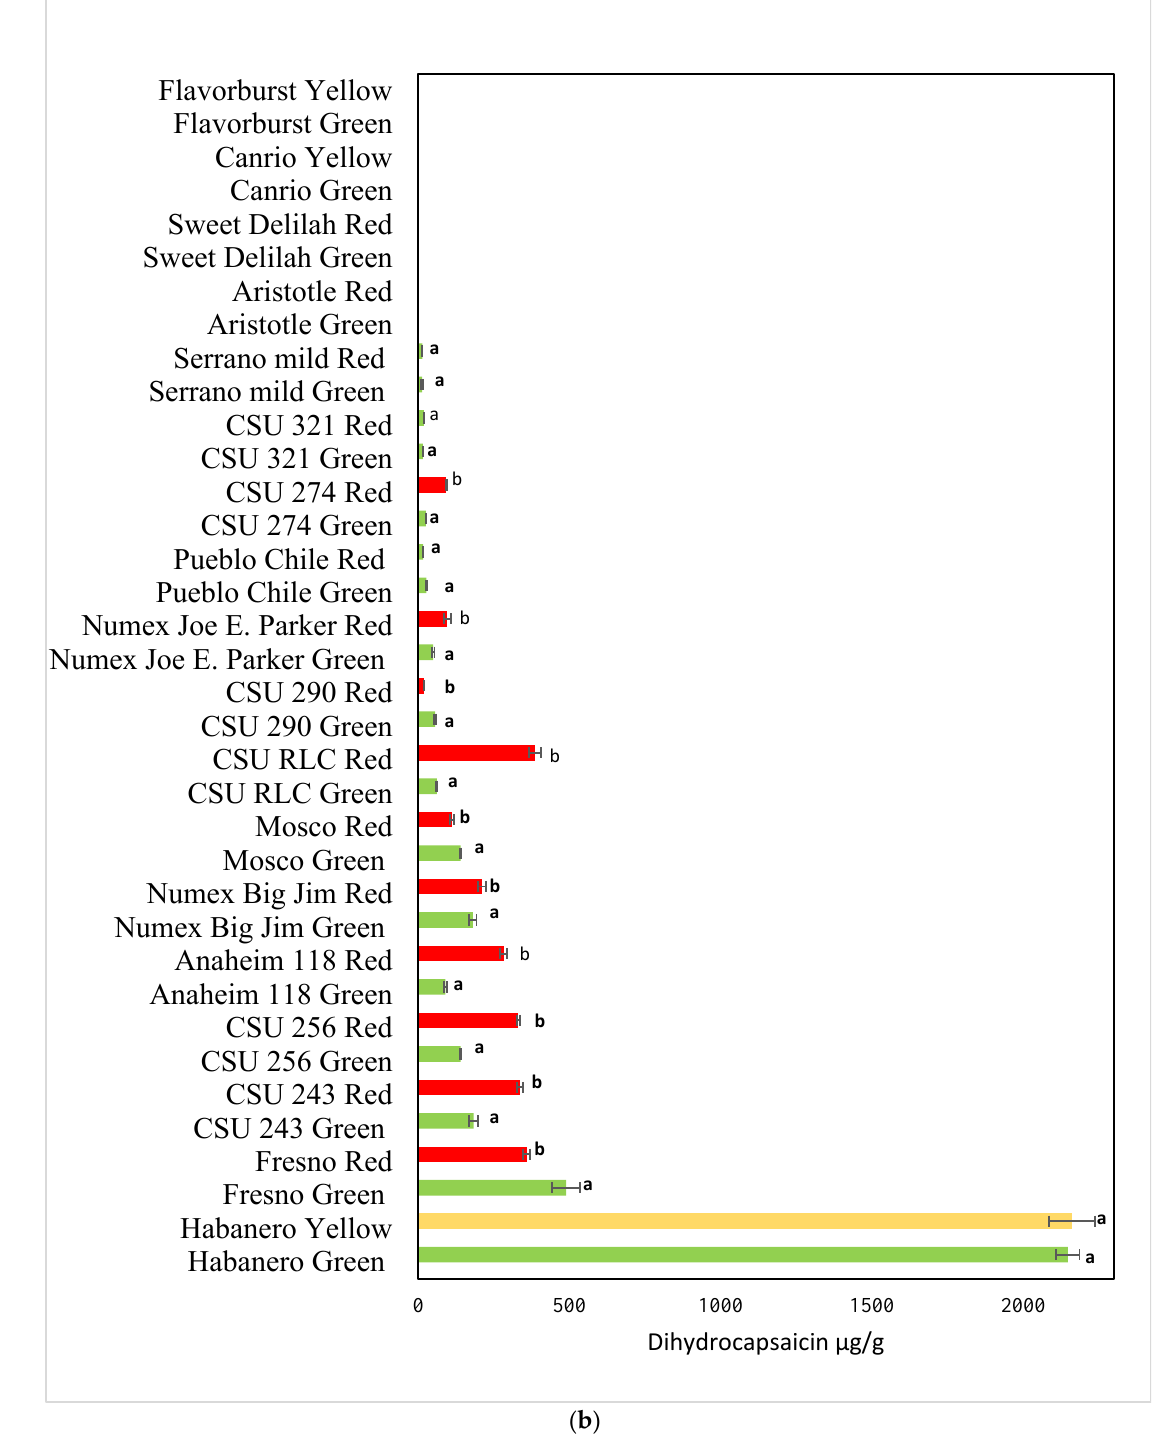
Figure 3. ( a ) Comparison of capsaicin levels in C. annuum cultivars and Habanero. Data are the mean of three replicates with standard deviation and are expressed as per gram freeze-dried weight. Significant differences are denoted by different letters, while the same or shared letters indicate that they are not significant to each other. ( b ) Comparison of dihydrocapsaicin levels in C. annuum cultivars and Habanero. Data are the mean of three replicates with standard deviation and are expressed as per gram freeze-dried weight. Significant differences are denoted by different letters, while the same or shared letters indicate that they are not significant to each other.